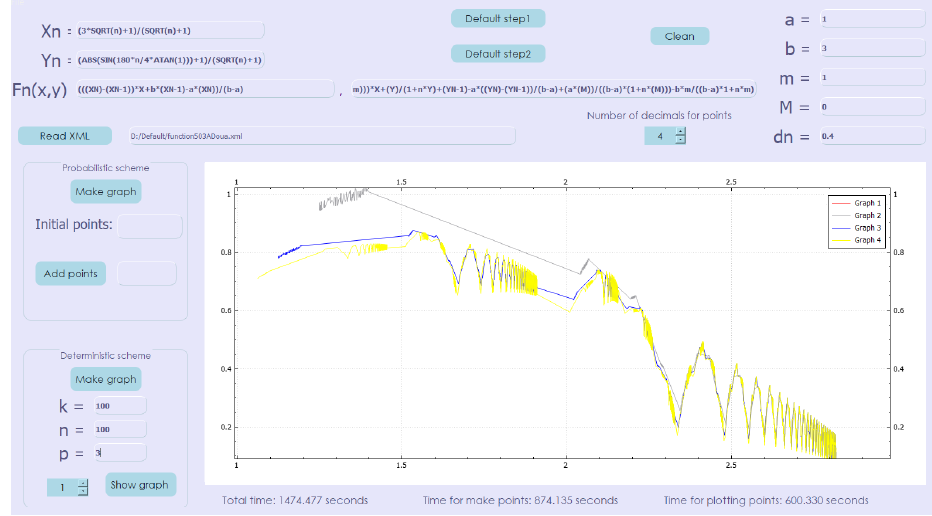
Figure 4. Non-affine deterministic interpolation scheme (approximation with 100,000,000 points), plotting the graph of every step in the